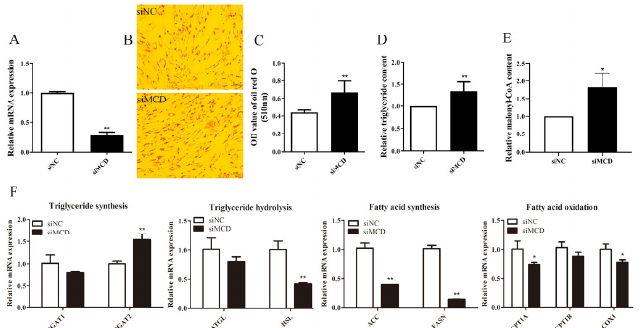
Figure 4. Silencing of MCD increased cellular lipid accumulation and triacylglycerol (TAG) content. ( A ) MCD interference efficiency detection. ( B ) Cellular lipid droplets were observed through a microscope (10 µ m) after using Oil Red O staining. ( C ) The OD assay was performed at 510 nm by dissolving Oil Red O stain with isopropyl alcohol. ( D ) Effect of knockdown of MCD on intracellular TAG content. ( E ) Detection of intracellular malonyl-CoA levels by ELISA. ( F ) Effect of MCD knock- down on expression of genes related to lipid metabolism. Results are presented as “Means ± SD”, n = 3. ** p < 0.01, * p < 0.05. siNC: Negative control siRNA treatment as control; siMCD: siRNA-MCD treatment.